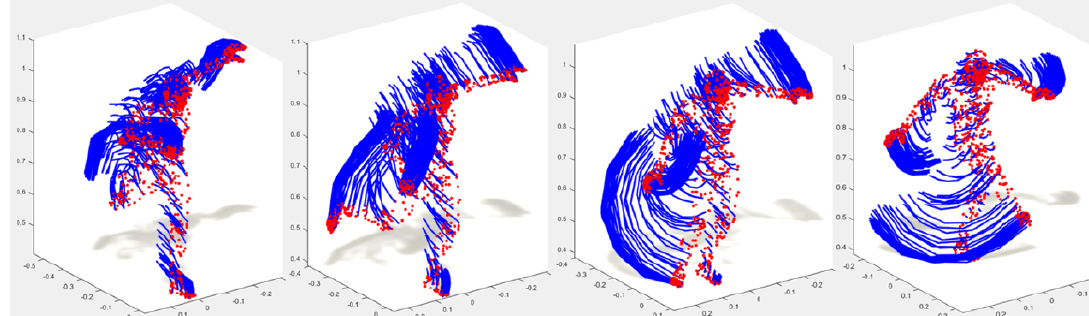
Figure 7. Three-dimensional dense trajectories of the target view obtained by following each feature point during the interval of time t . This can be further interpreted as the set of positions occupied by each feature point of the target view [16].